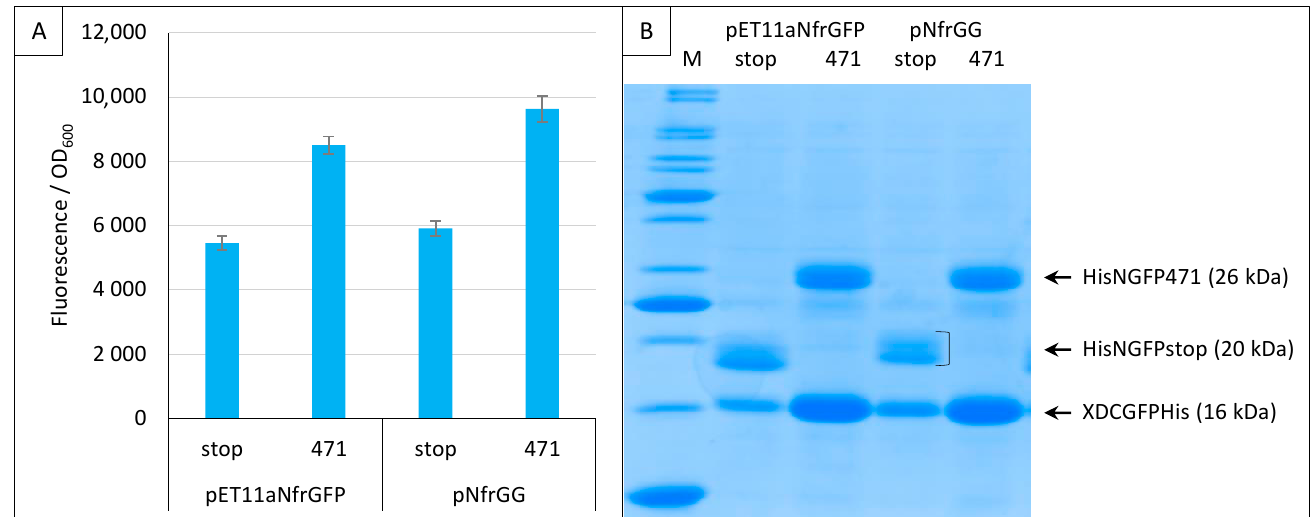
Figure 10. Gateway vector for expressing NfrGFP fusions. Split-GFP reassembly assay results as obtained with the Gateway and non-Gateway versions of plasmids expressing NfrGFP fusions and with the negative (stop) and positive (471) controls of the 471/XD interaction with the fr GFP reporter at 17 °C. Only pMRBad encoding XD-CfrGFP-His was used. ( A ) Fluorescence to OD 600 ratios. ( B ) SDS-PAGE analysis of the expression of the NGFP and CGFP fusions. M, molecular size markers (200, 150, 100, 85, 70, 60, 50, 40, 30, 25, 20, 15, 10 kDa).